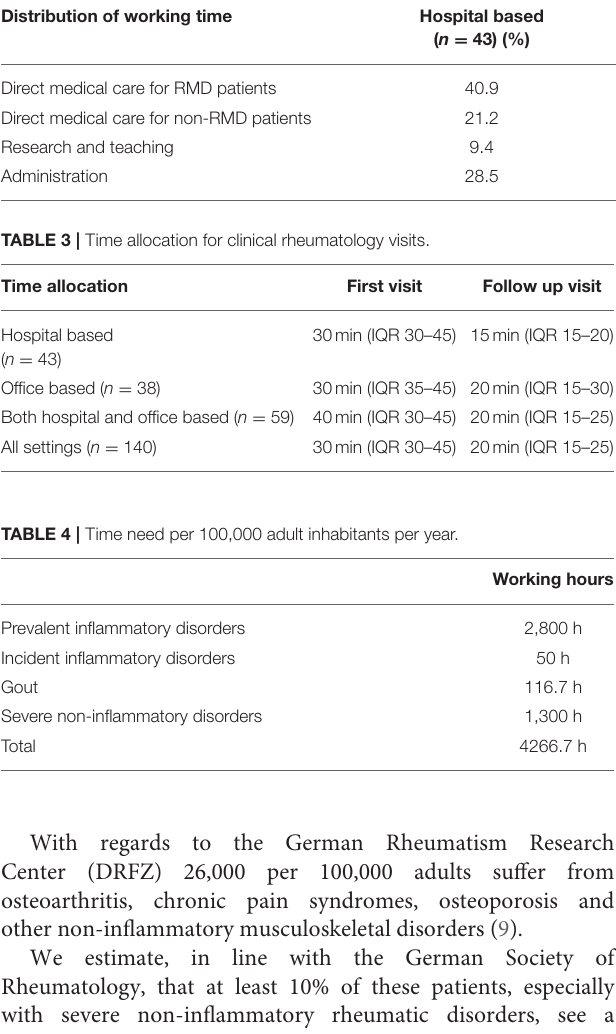
TABLE 2 | Distribution of working time according to workplace setting. Distribution of working time Hospital based